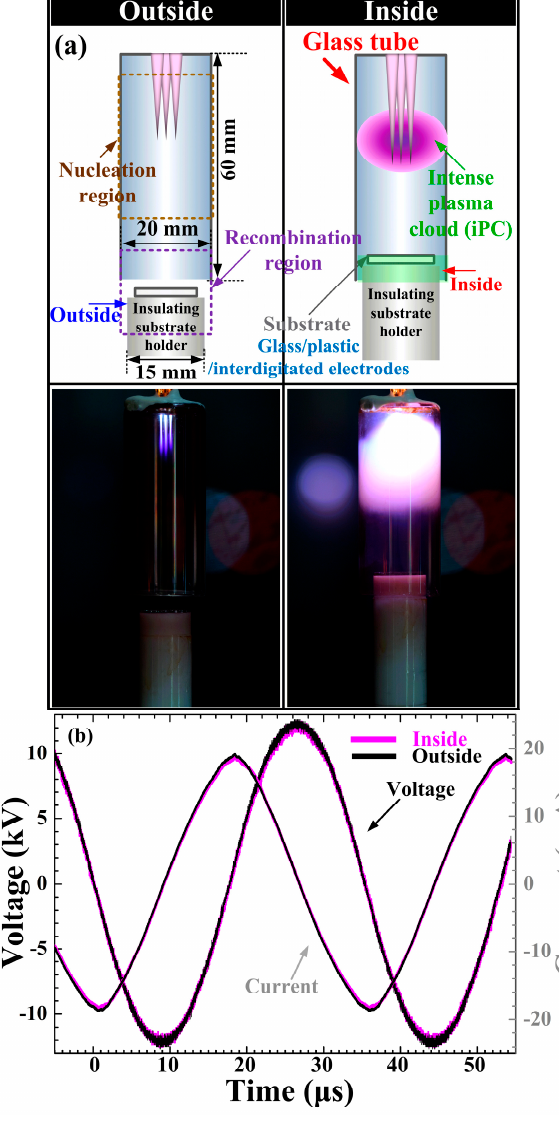
Figure 1. ( a ) Schematic diagram of experimental setup in this study and images of plasmas produced in the nucleation region; and ( b ) applied voltages and total currents of novel atmospheric pressure plasma jets (APPJs) whose insulating substrate holders (or polytetrafluoroethylene (PTFE) bottom cap) are placed outside or inside the glass tube.